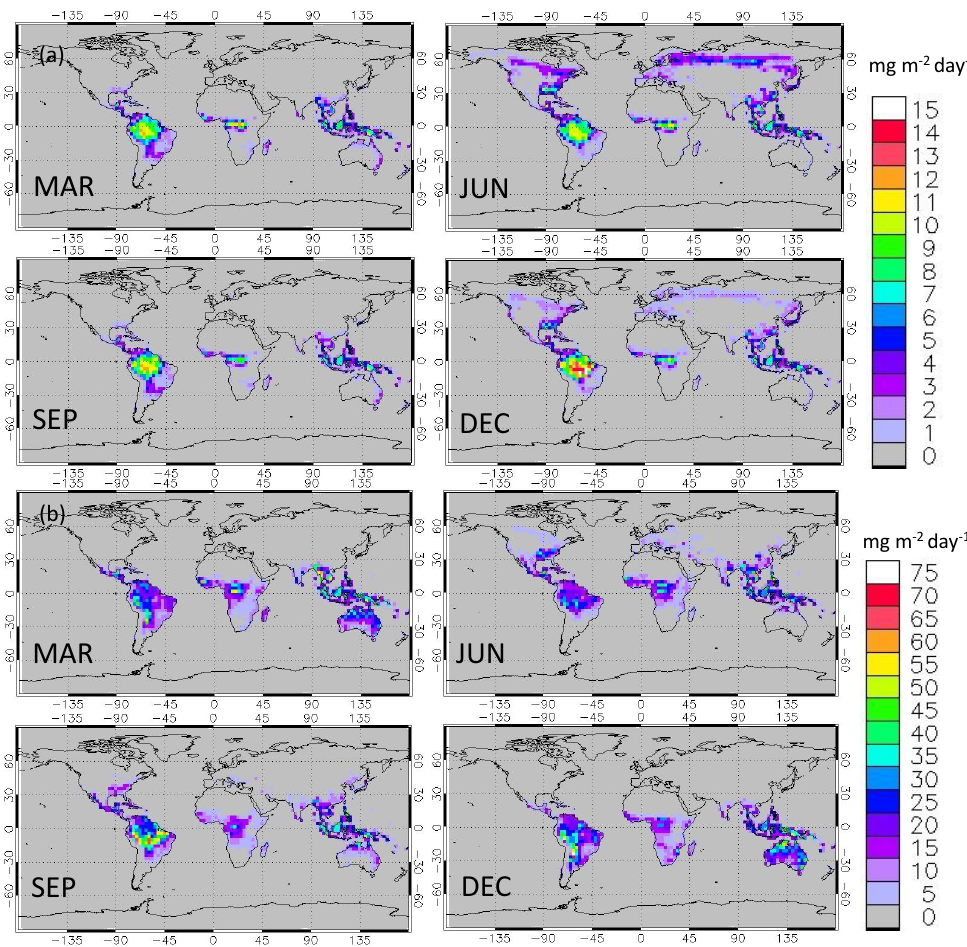
Fig. 2. Global distributions of monthly average emission rates (mgm − 2 day − 1 ) for (a) summed monoterpenes (C 10 H 16 ) , and (b) isoprene (C 5 H 8 ) at the surface. Examples are shown for representative months in different seasons of the year. 5